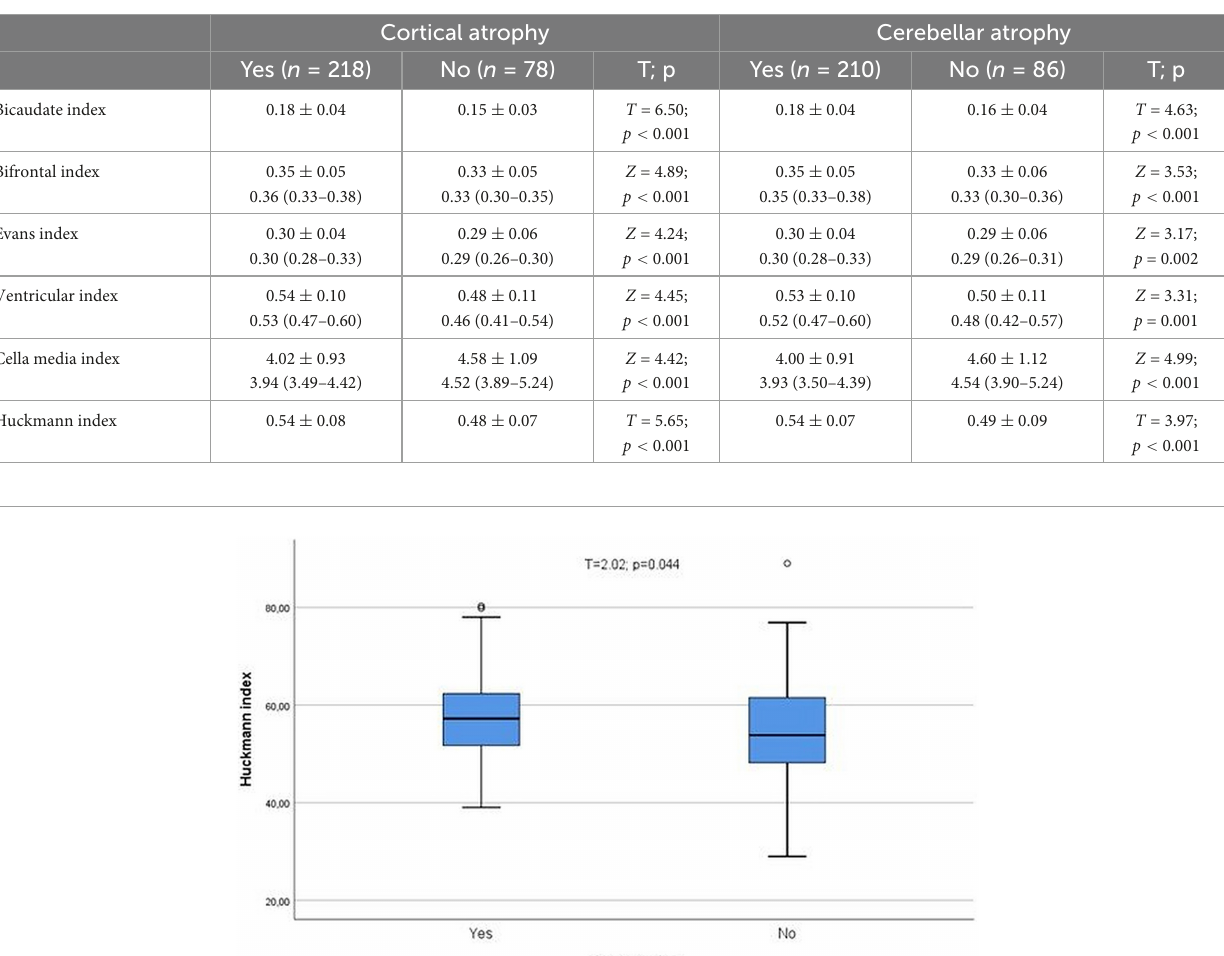
TABLE 2 Differences in CT indices in patients with or without cortical and cerebellar atrophy.